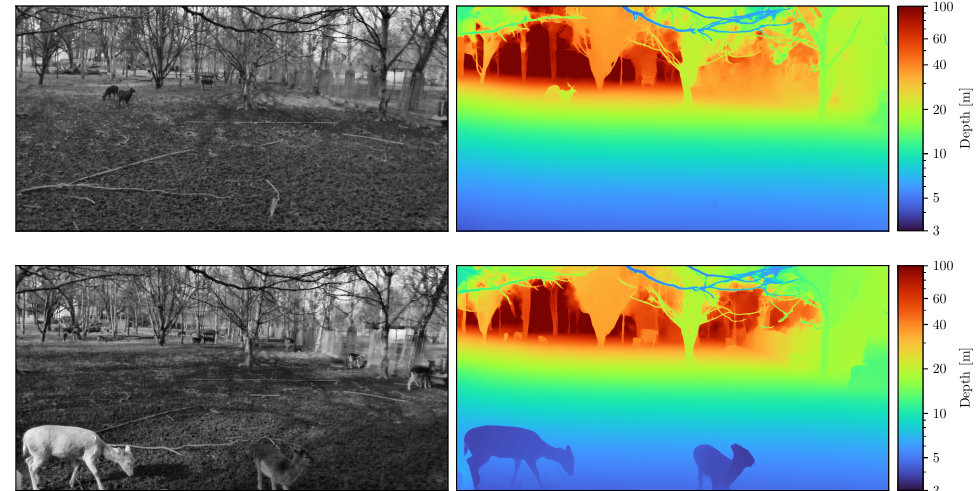
Figure 2. Samples of data collected in the wildlife park Plittersdorf. The left shows the grayscale image of the left camera, the right image the color-coded depth map obtained using stereo